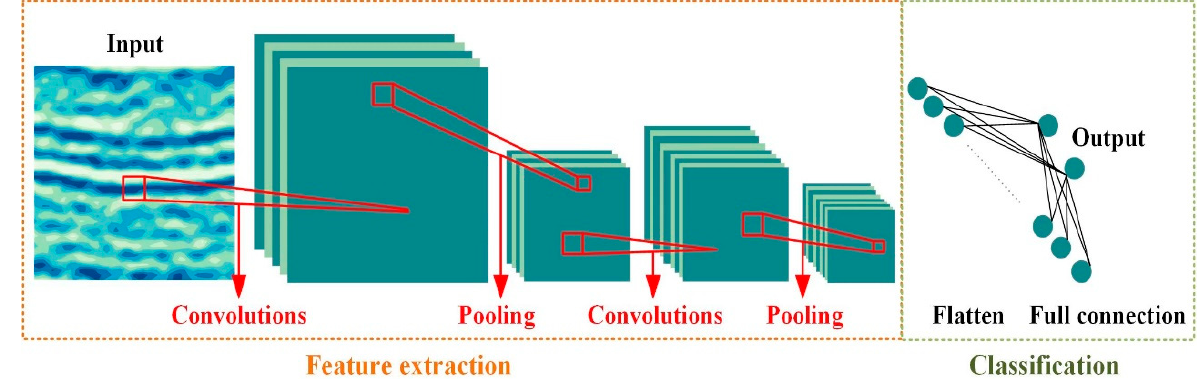
Figure 2. The architecture of the CNN model.